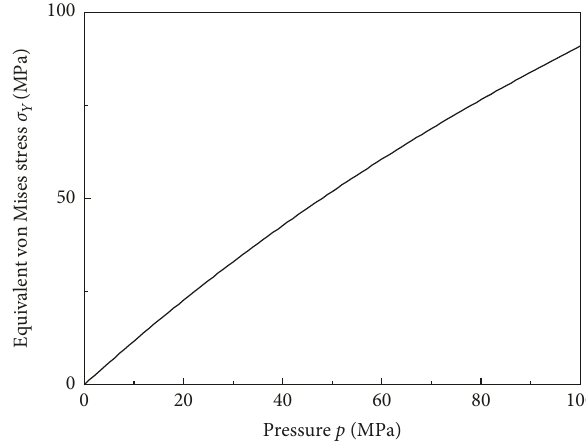
Figure 11: Lundborg yield surface of the calcareous sand.